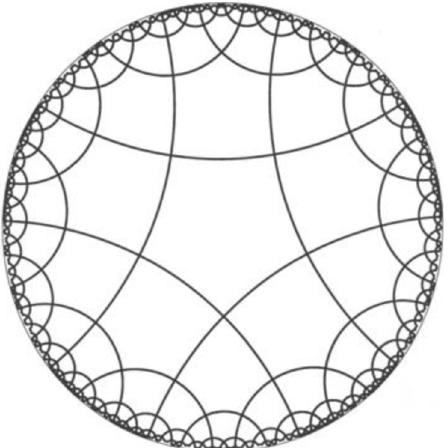
Figure 1 . The right-angled pentagon tiling of the hyperbolic plane H 2 used in the construction of the HaPPY